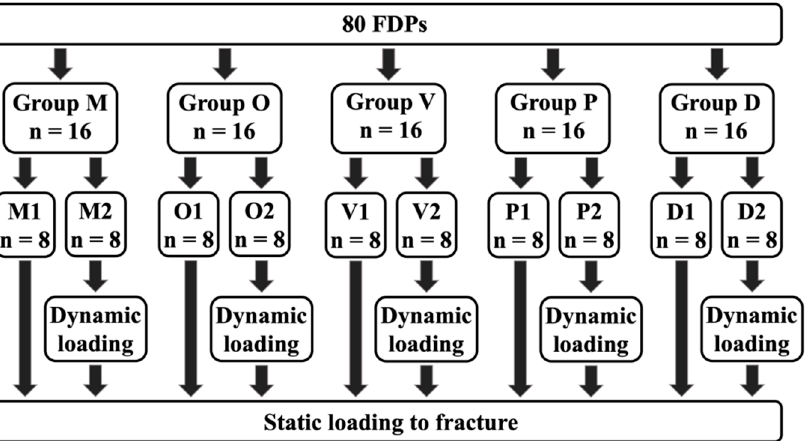
Figure 3. Groups: (M) milled, (O) occlusal, (V) vertical, (P) palatal, (D) diagonal, (1) non-aged, (2) aged.